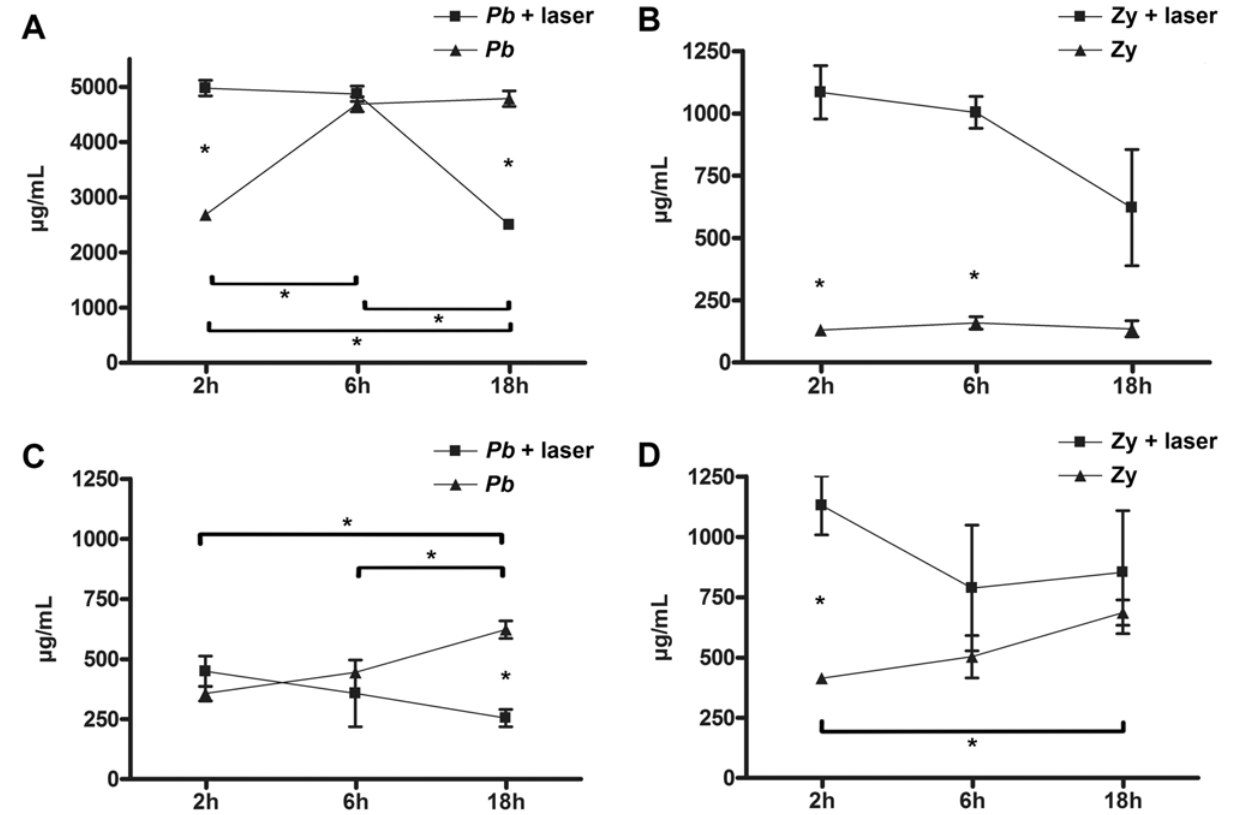
Fig 5. PMN protein production. Protein production kinetics of irradiated and non-irradiated PMN. A — Pb infected mice (non-irradiated and irradiated); B — Zymosan (Zy) inoculated mice (non-irradiated and irradiated); C — PMN recruited by Pb infection and co-cultivated with Pb ; and D — recruited by Zy inoculation and co-cultivated with Pb . A: p = 0.002 ( * ) between 2 and 6 hours of Pb non-irradiated; p = 0.0001 ( * ) between Pb non-irradiated and Pb irradiated at 2 hours; p = 0.001 ( * ) between 2 and 18 hours of Pb irradiated PMN; p = 0.001 ( * ) between 6 and 18 hours of Pb irradiated PMN; and p = 0.001 ( * ) between the Pb irradiated and non-irradiated PMN at 18 hours; B : p = 0.009 ( * ) between Zy non-irradiated and Zy irradiated at 2 hours; and p = 0.003 ( * ) between Zy non-irradiated and Z irradiated at 6 hours; C: p = 0.005 ( * ) between the non-irradiated PMN of the Pb group at 2 and 18 hours of co-cultivation; p = 0.0481 ( * ) between the non-irradiated PMN of the Pb group at 6 and 18 hours of co-cultivation with Pb ; and p = 0.002 ( * ) between the non-irradiated and irradiated PMN at 18 hours of co-cultivation; D: p = 0.0043 ( * ) between the non-irradiated and irradiated PMN at 2 hours of co-cultivation; p = 0.0069 ( * ) between the non-irradiated PMN at 2 and 18 hours of